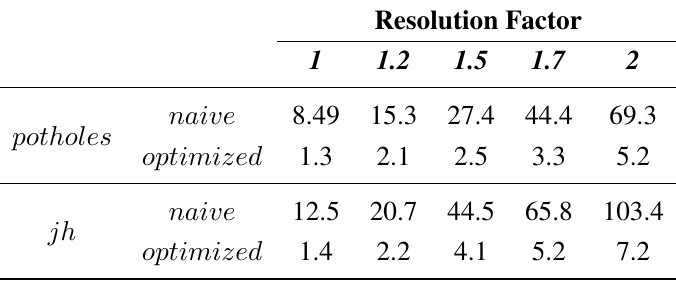
Table 2. Computational time (in minutes) spent in the expansion phase of the Voronoi computation for the environments potholes and jh . For both variants of the